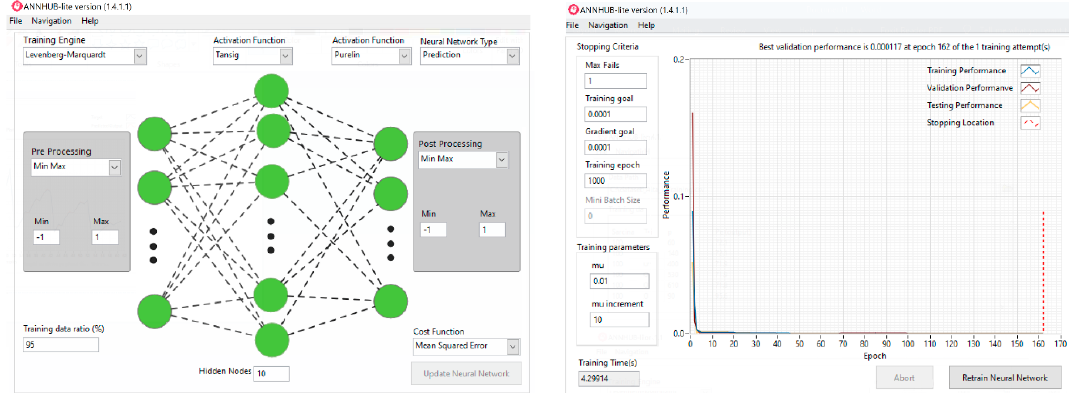
Figure 12. ANNHUB TM configuration of the Levenberg–Marquardt algorithm and training